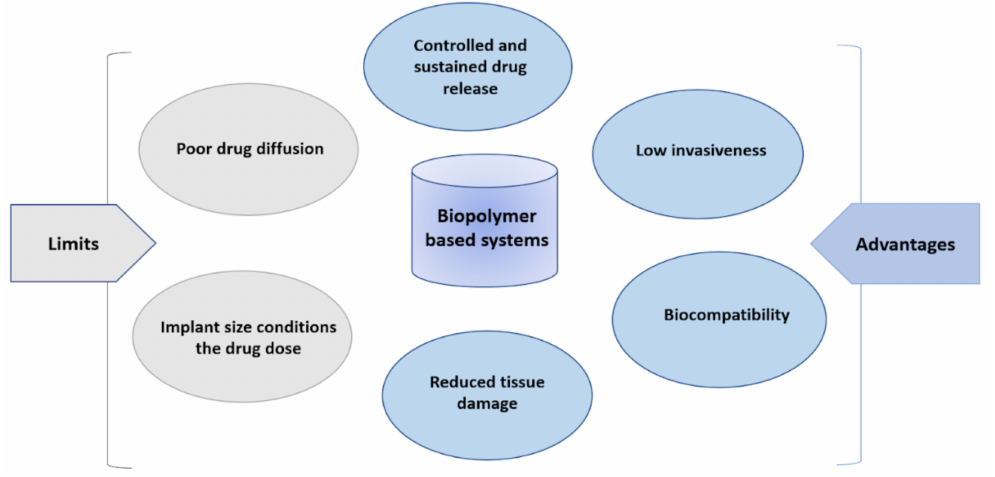
Figure 5. Characteristics of polymer-based devices for central nervous system